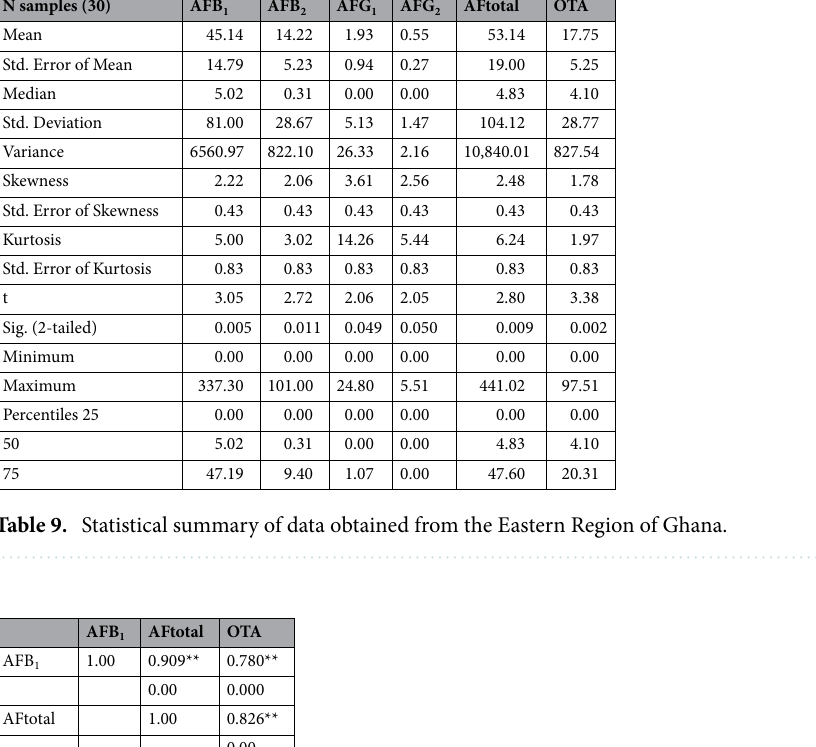
Table 10. Associations of mycotoxins (AFB 1 , AFtotal and OTA) in maize from Eastern Region. **Correlation is significant at the 0.01 level (2-tailed).